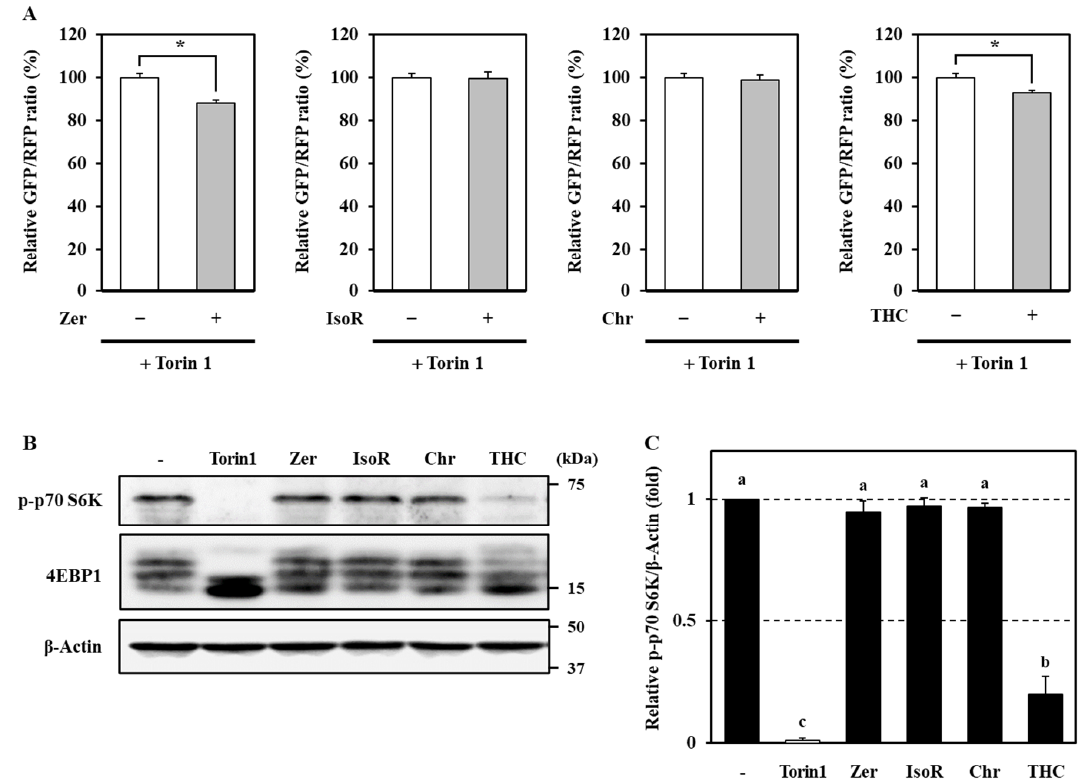
Figure 6. mTOR signaling contribution to the autophagy-promoting e ff ects of phytochemicals. Transgenic Caco-2 cells were treated with Torin1 (1 µ M) and / or each flavonoid (20 µ M) for 4 h. To determine the autophagy flux, intracellular fluorescence intensities were measured using a Cellometer ® Vision instrument to obtain GFP / RFP ratios ( A ). mTORC1 activity was assessed by determining the level of phospho-p70 S6K and 4EBP1 band shifts. β -Actin was used as an internal control ( B , C ). Data represent the mean ± SEM of triplicate measurements. Statistical significance was assessed by unpaired t -test (* p < 0.05) ( A ). The di ff erent letters indicate significant di ff erences as determined using the Tukey–Kramer test ( p < 0.05) ( C ). Zer, zerumbone; IsoR, isorhamnetin; Chr, chrysoeriol; THC, 2,2 (cid:48) ,4 (cid:48)